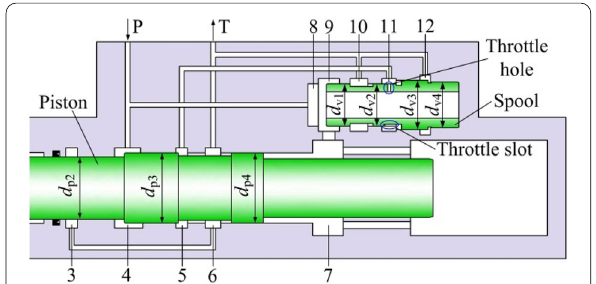
Figure 4 Structure of the SSPWJ generation